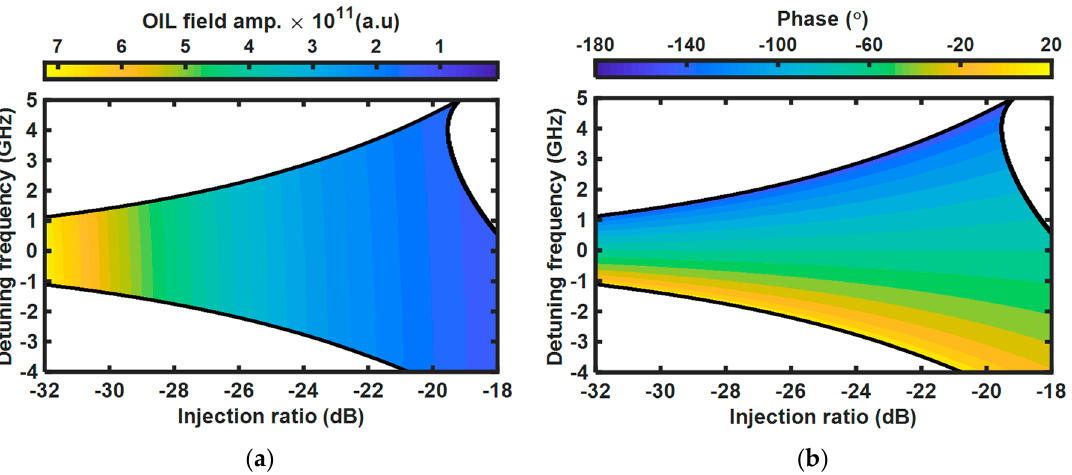
Table 1. Simulation parameters.